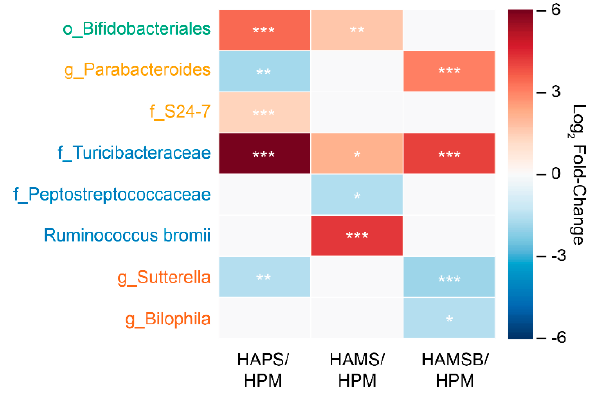
Figure 3. Bacterial taxa found in significantly di ff erent proportions in rats fed resistant starch (RS) diets, compared to the rats fed the HPM diet. The log 2 -transformed, fold-changes of the relative abundance of bacteria in the RS diets, compared to the HPM diet are shown. Only taxa that were significantly changed in an RS diet compared to HPM are shown. A log 2 fold-change greater or equal to 1.0 and a p -value < 0.05, determined by the Wald test in DESeq2, was necessary to be considered significant. The scale represents the log 2 -fold change, and the heatmap is annotated such that * p < 0.05, ** p < 0.01, *** p < 0.001. The taxon names are colored according to the phyla as follows—Actinobacteria (green), Bacteroidetes (gold), Firmicutes (blue), and Proteobacteria (orange).